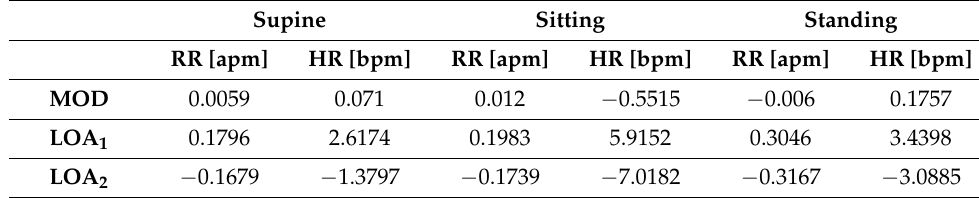
Table 3. Bland–Altman summary